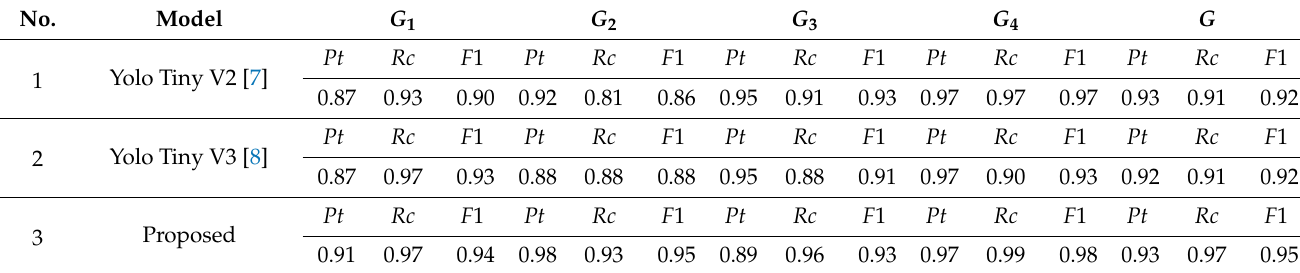
Table 2. Comparison of 20 groups of remote sensing data test results [ Pt , Rc , F